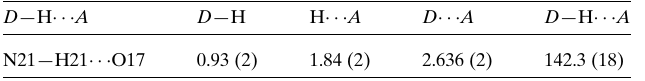
Table 1 Hydrogen-bond geometry (A˚ , (cid:2)